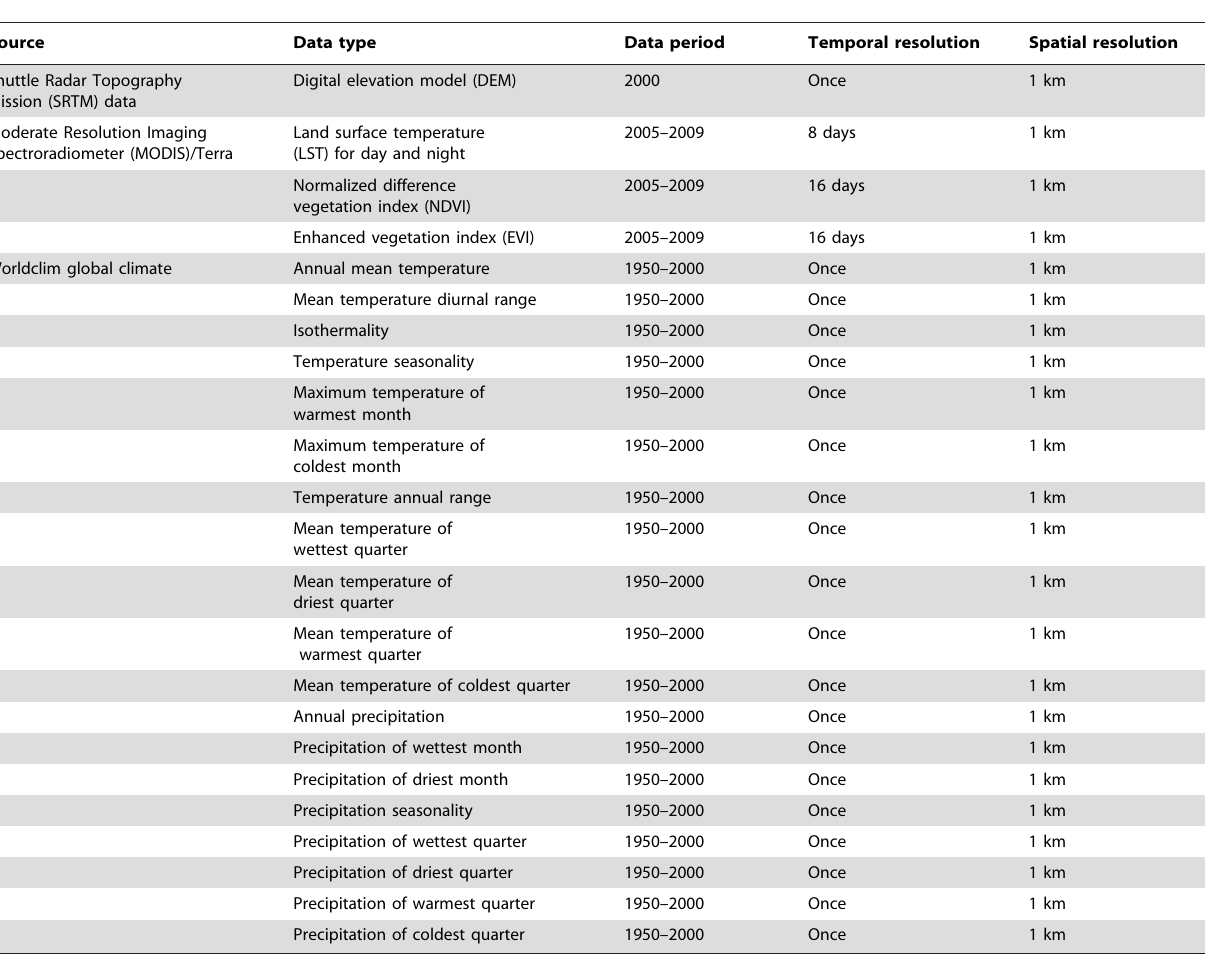
Table 1. Climatic and environmental predictors used for geostatistical modeling of leishmaniasis in